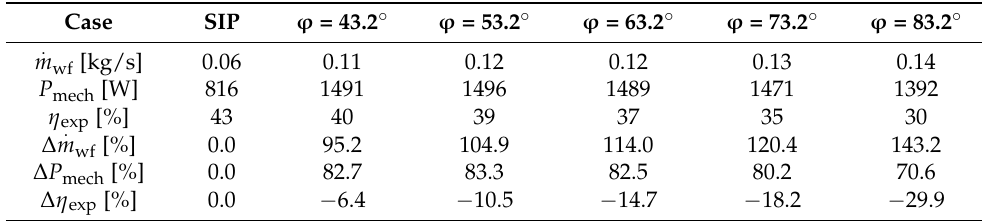
Table 6. Comparison between the SIP and DIP SVRE